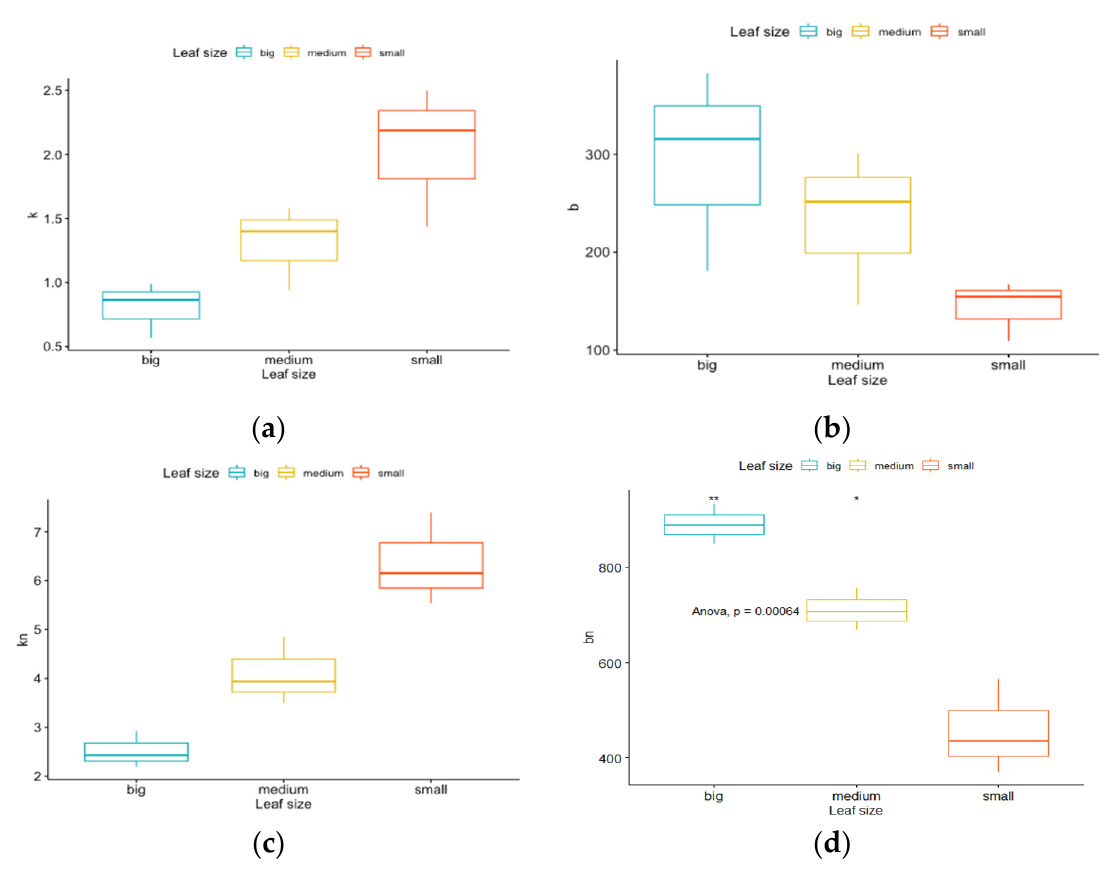
Figure 8. The parameters of the relationship ( 𝑦 = 𝑘𝑥 + 𝑏 , 𝑥 = leaf area, 𝑦 = light interception) between the light interception and leaf area cumulated from the top of the plant to the lowest by layers, fitted by the simulated result of the center plants (n = 6). ( a ) the boxplot of the slopes 𝑘 among big-leaf, medium-leaf, and small-leaf canopies with different incident radiation and ratios of diffuse light (s1, s2, s3). ( b ) the boxplot of intercepts 𝑏 among big-leaf, medium-leaf, and small-leaf canopies with different incident radiation and ratios of diffuse light (s1, s2, s3). ( c ) the boxplot of slopes 𝑘𝑛 among big-leaf, medium-leaf, and small-leaf canopies with the same incident radiation and ratios of diffuse light (sn1, sn2, sn3). ( d )the boxplot of intercepts 𝑏𝑛 among big-leaf, medium-leaf, and small-leaf canopies with the same incident radiation and ratios of diffuse light (sn1, sn2, sn3). Scenarios include s1 (27.8% of diffuse light, 426.41 µmol/m 2 s of incident PAR), s2 (48.7% of diffuse light, 336.16 µmol/m 2 s of incident PAR), and s3 (89.6%of diffuse light, 183.18 µmol/m 2 s of incident PAR); the scenarios of normalized incident radiation (sn1, sn2, and sn3) have the same ratios of diffuse light as s1, s2, and s3 respectively.